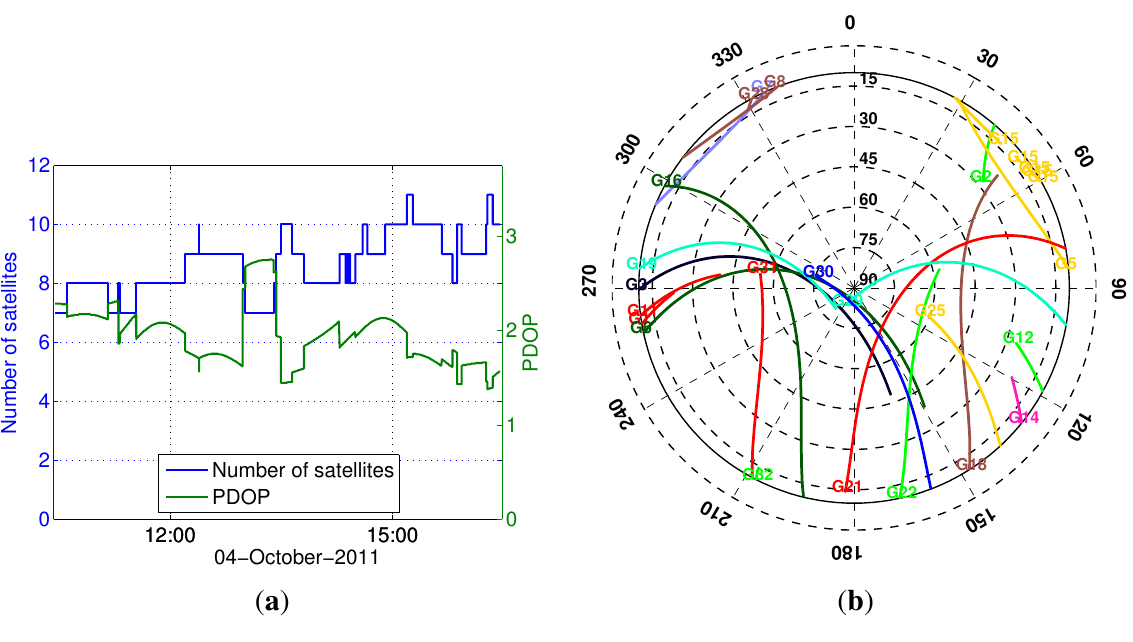
Figure 3. GPS satellite visibility during the static experiment with a 10 ◦ elevation cut-off. ( a ) The number of satellites and position dilution of precision (PDOP); and ( b )